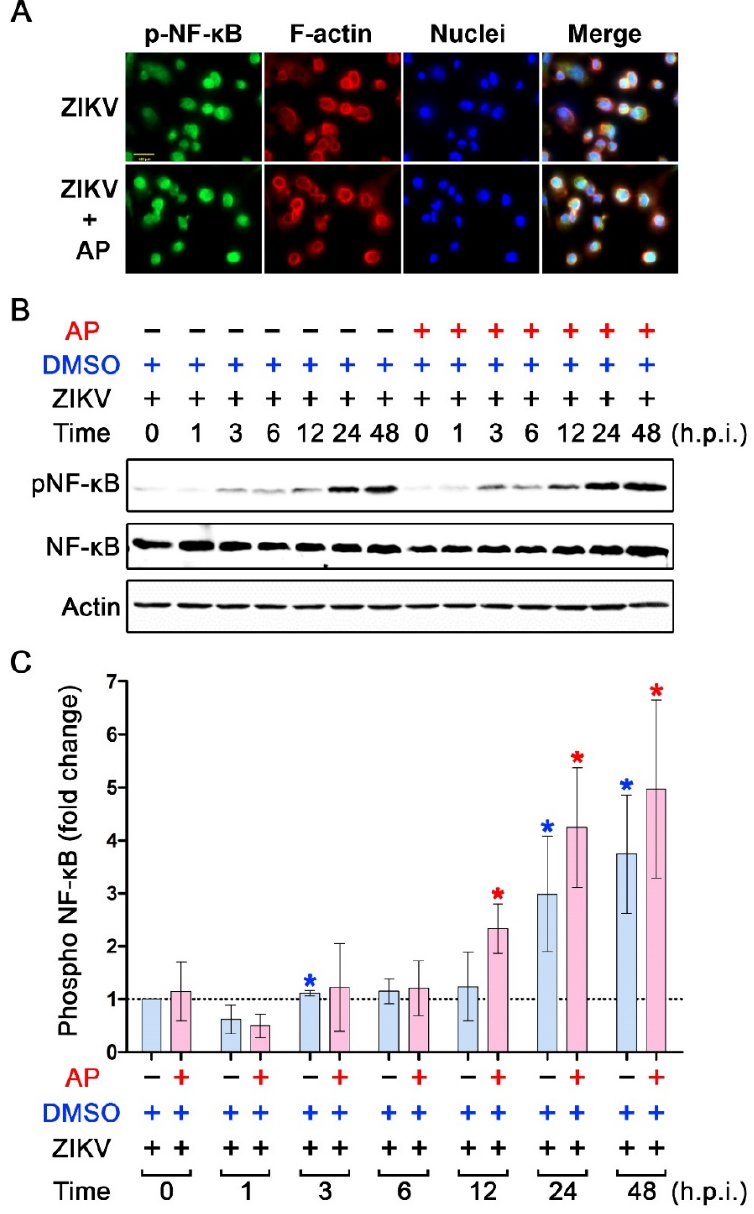
Figure 6. Effects of AP on the activation status of NF- κ B in THP-1 macrophages infected with ZIKV. ( A ) Immunofluorescence study detecting the presence of NF- κ B (green) in the nucleus of THP-1 macrophages infected with ZIKV at MOI 5 for 48 h. F-actin (red) was stained with DyLight TM 594-Phalloidin, and nuclei of cells (blue) were stained with DAPI. Scale bar = 500 µ m. ( B ) Western blot analysis detecting phosphorylated NF- κ B (p-NF- κ B), total NF- κ B (NF- κ B), and actin in the lysates of THP-1 macrophages infected with ZIKV at 5 MOI with or without post-treatment with 6.25 µ M AP at various time points (0–48 h). ( C ) Densitometric quantification of p-NF- κ B immunoreactive bands versus total NF- κ B in the lysates of THP-1 macrophages infected with ZIKV at 5 MOI with or without post-treatment with 6.25 µ M of AP at various time points (0–48 h). Actin was used as an internal control. * p < 0.05 (red asterisk (compared to the AP-treated group at 0 h) and blue asterisk (compared to the DMSO control group at 0 h)). h.p.i. = hour(s) post-infection. Densitometry scans and uncropped blots are presented in Supplementary Materials.